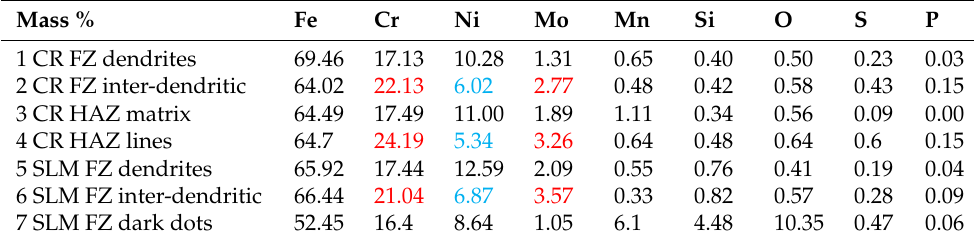
Table 6. Local compositions of welded samples measured by SEM-EDX. Red and blue colors highlight an element with a rich or poor composition,